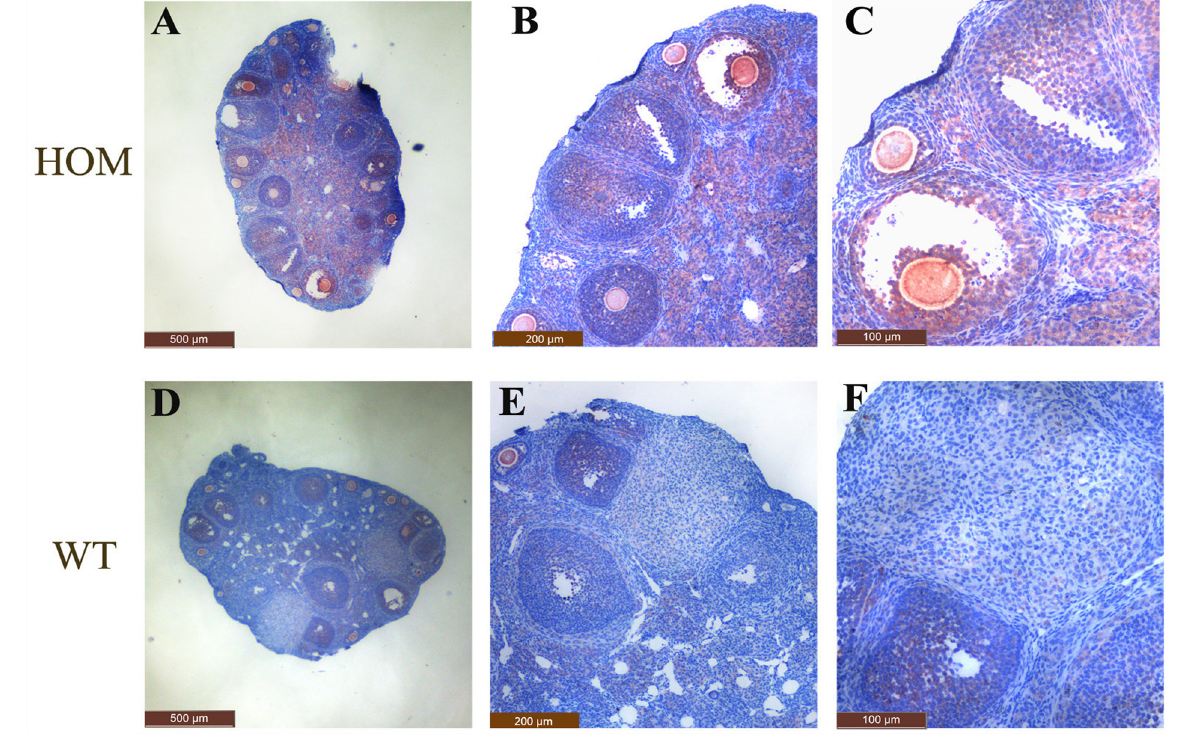
Fig 2. Immunohistochemical detection of LepR in HOM and WT ovaries. Panel A, B, C: LepR expression in HOM ovaries observed at 4×10 magnification, 10×10 magnification and, 20×10 magnification, respectively. Panel D, E, F: LepR expression in WT ovaries observed at 4×10 magnification, 10×10 magnification and 20×10 magnification, respectively. LepR expression was mainly detected at the surfaces of theca cells and granulosa cells of follicles. The total expression level of LepR in WT ovaries was significantly lower than in HOM